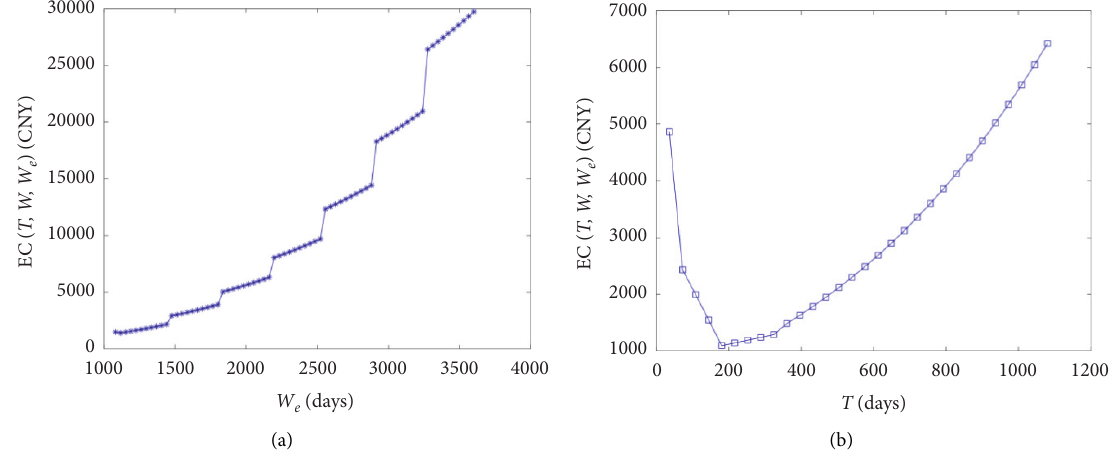
Figure 6: EW cost change when T � 360 days and W